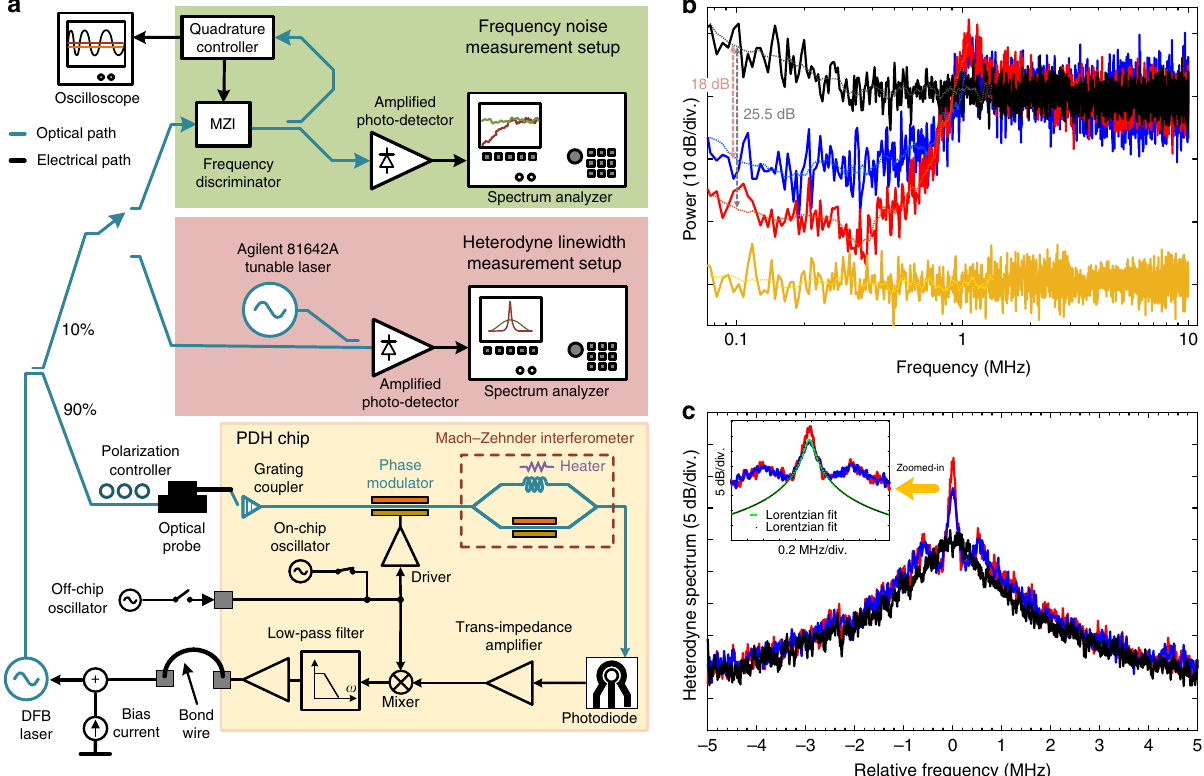
Fig. 6 Frequency noise spectra and beat note spectral measurement. a The frequency noise and heterodyne linewidth measurement setups. For the frequency noise measurements, an optical fi ber based Mach − Zehnder interferometer (MZI) is utilized as a frequency discriminator (Supplementary Note 4). The phase difference between the two arms of the MZI is set to 90 o using the quadrature controller. To measure the heterodyne linewidth of the distributed feedback (DFB) laser before and after Pound − Drever − Hall (PDH) stabilization, the beat note between the DFB laser and an Agilent 81642A tunable laser is monitored on an electrical spectrum analyzer. b Frequency noise measurement. The measured closed-loop response of the reported PDH system is shown where the original frequency noise of the laser (black) is reduced by more than 25 dB (for A i = 112 dB) when an off-chip 150 MHz oscillator is used (red) and by more than 18 dB when the on-chip 280 MHz oscillator is used (blue). The noise fl oor of the measurement setup is shown in yellow. c The full-width at half-maximum (FWHM) linewidth measurement. The beat note between the DFB laser and an Agilent 81642A tunable laser is monitored on an Agilent 8563E electrical spectrum analyzer. Under the closed-loop condition, the linewidth of the free-running laser (black) is reduced using on-chip oscillator (blue) and off-chip oscillator (red). The inset shows the zoomed-in heterodyne spectra with Lorentzian fi ts